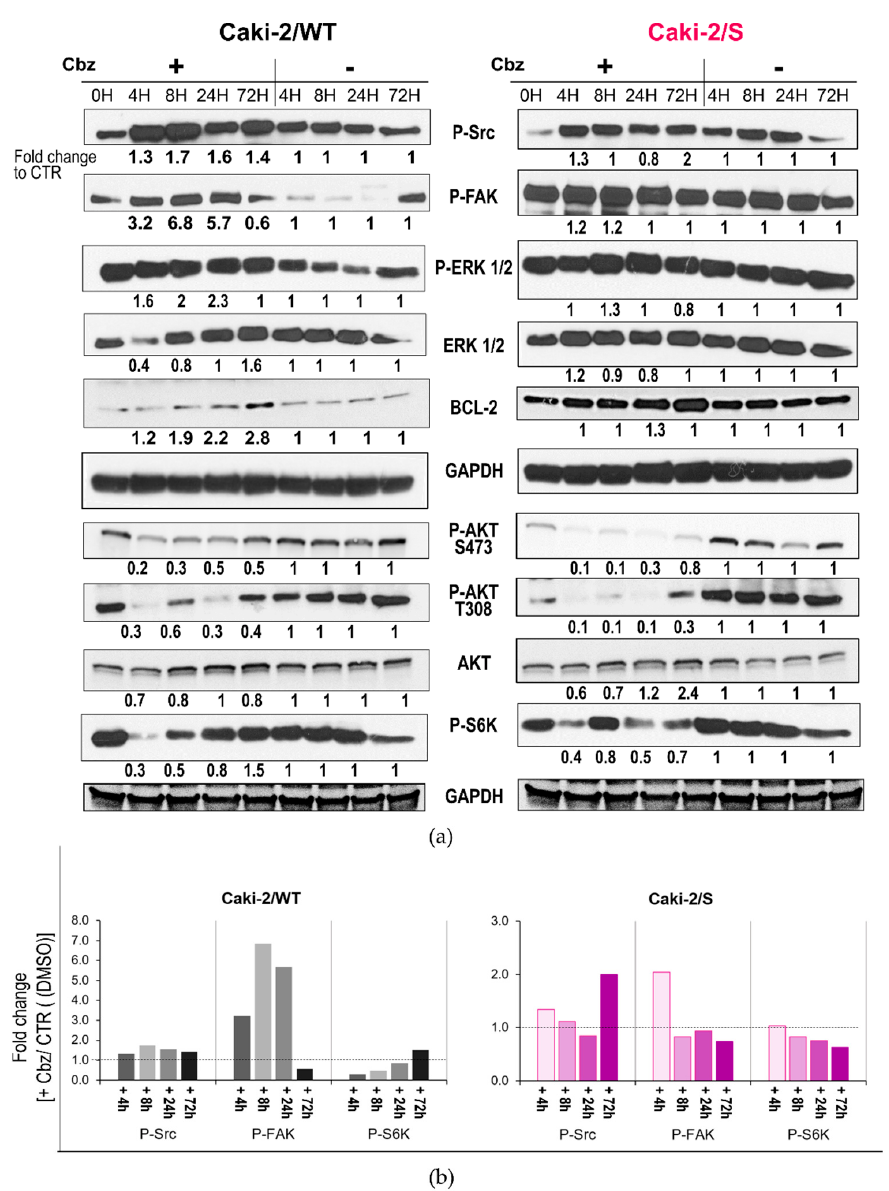
Figure 5. Effect of cabozantinib on signal transduction in human RCC treatment-naïve Caki-2/WT cells and following long-term treatment with sunitinib in Caki-2/S cell lines. ( a ) Cell lysates (20 µg) obtained from Caki-2/WT and Caki-2/S cells treated (+) with 12 µM of cabozantinib (Cbz) or untreated ( − ) with DMSO 0.1% at four time points were analyzed with an immunoblotting assay with specific antibodies for the indicated proteins. GAPDH expression was selected as the loading control of the samples. The optical density (OD) of the area of each band was quantified with ImageJ 1.52a software and normalized to that of GAPDH. Numbers below each line represent the fold changes of the target proteins, which were obtained by dividing the normalized expression from each lane by the normalized expression of the relative untreated controls (set as 1). ( b ) Comparative expression levels (fold change) of the P-Src, P-FAK and P-S6K proteins between cabozantinib-treated and untreated samples. The relative targeted protein expression (densitometry normalized to the loading control) of each cabozantinib-treated sample was compared with the corresponding DMSO-treated (control, CTR) samples (set as 1) to assess the fold change occurring under the two experimental conditions. Representative immunoblotting image and relative quantification. Full-length blots of independent duplicates are presented in Supplementary Figures S7–S10. The figure was generated with Inkscape (version 1.0.2, RRID: SCR_014479).